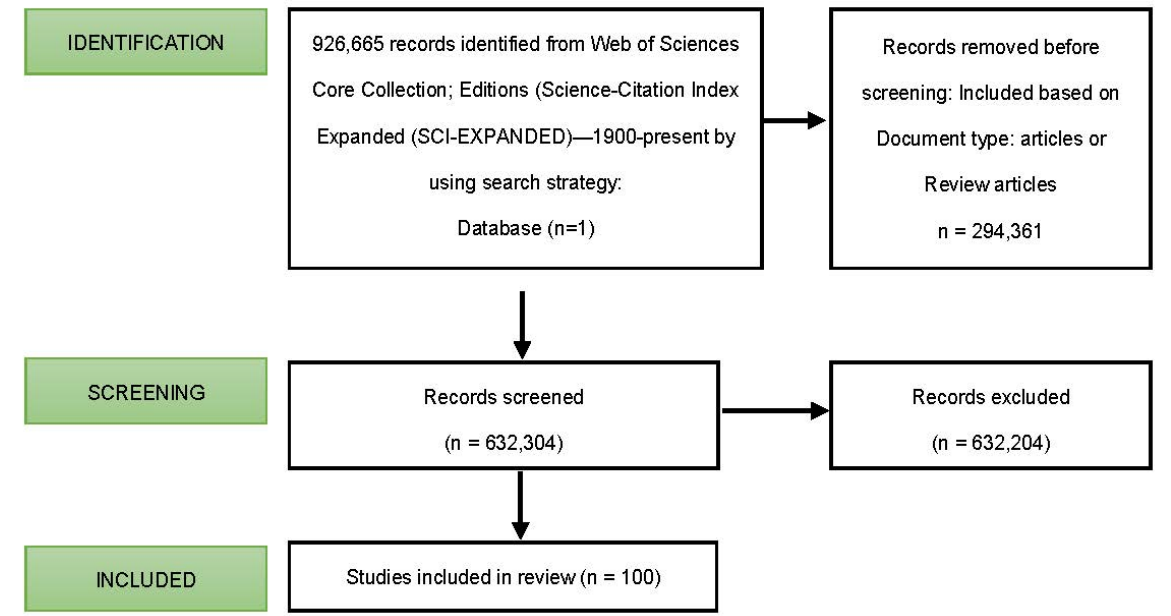
Figure 1. Flowchart of